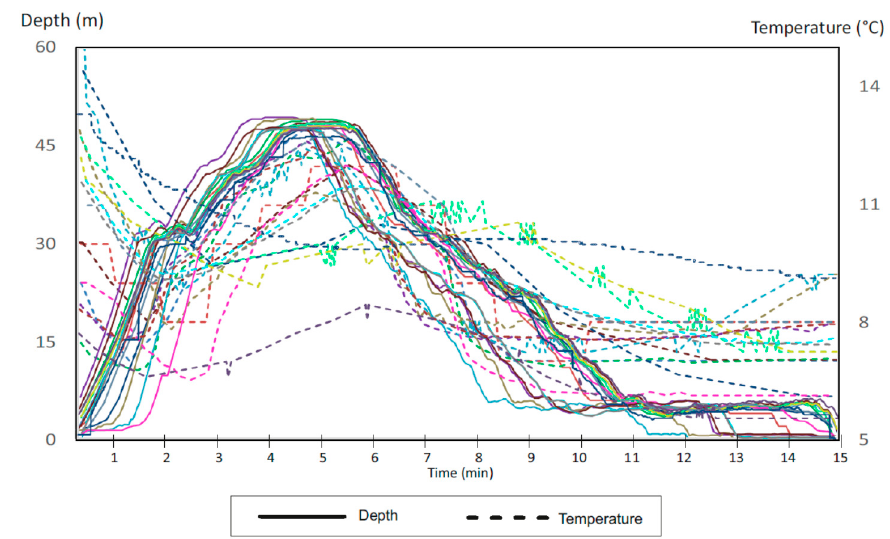
Figure 4. Temperature and depth profiles for the dives in Bosporus. Solid lines are for depth and dotted lines are for temperature.